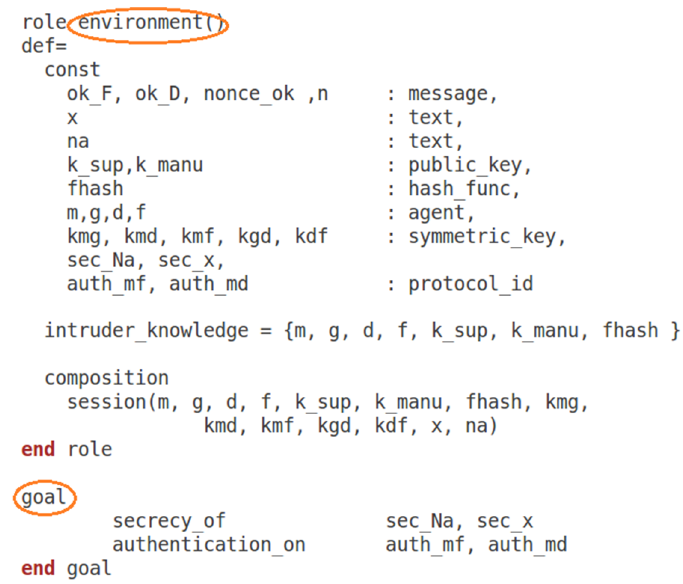
Figure 8. Environment and goal definitions in HLPSL under SPAN software [22].